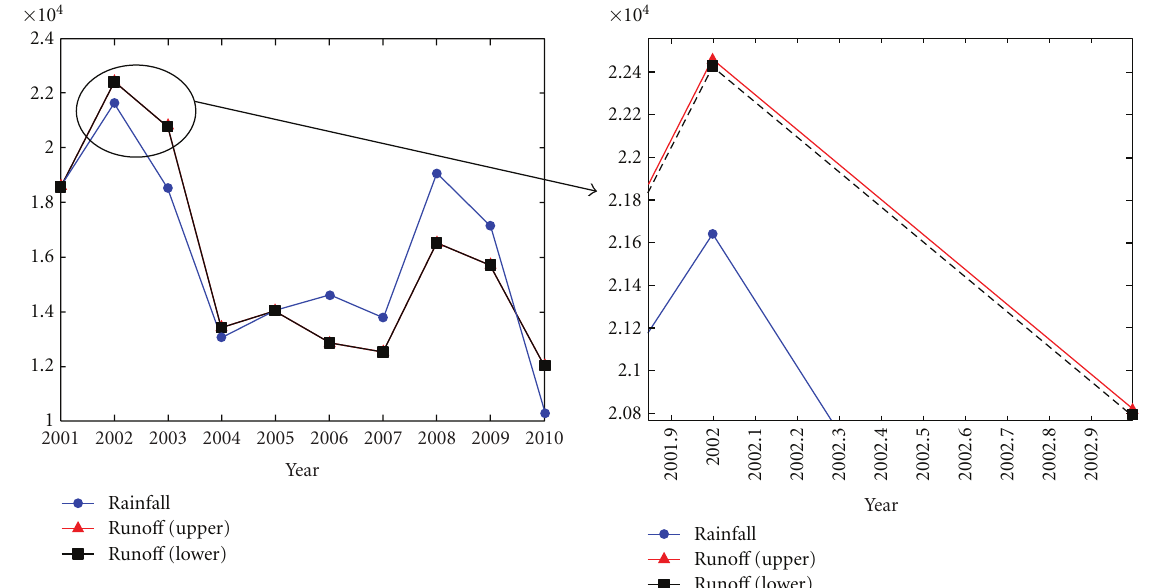
Figure 6: The similar patterns of rainfall and runo ff at the minimum distance from 2001 to